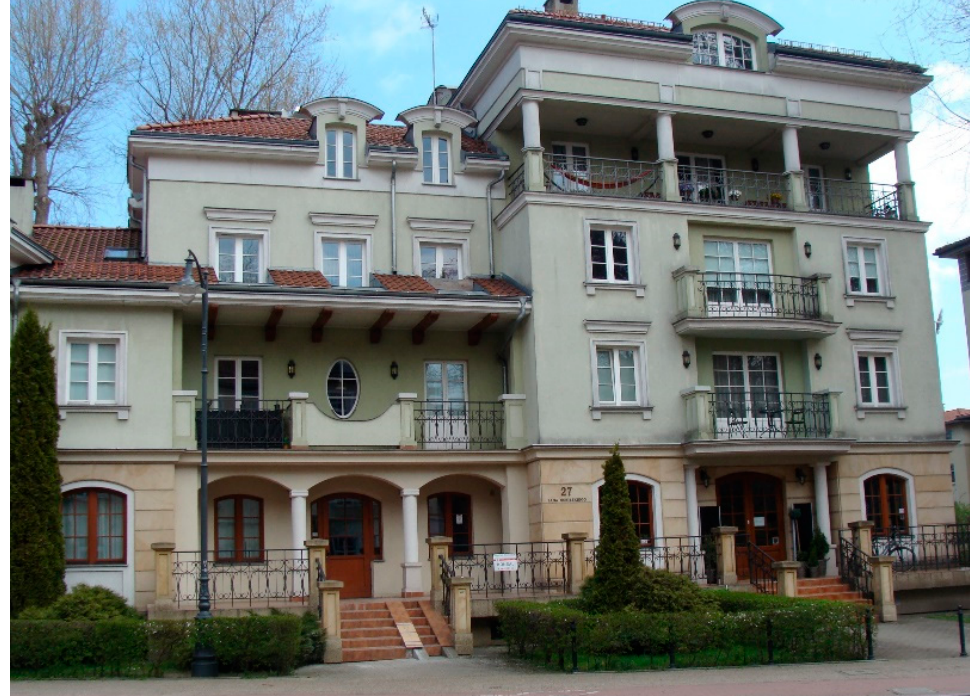
Figure 3. Residential building completed in 2003, Jana Sobieskiego street in Sopot. Source: A. Taraszkiewicz.